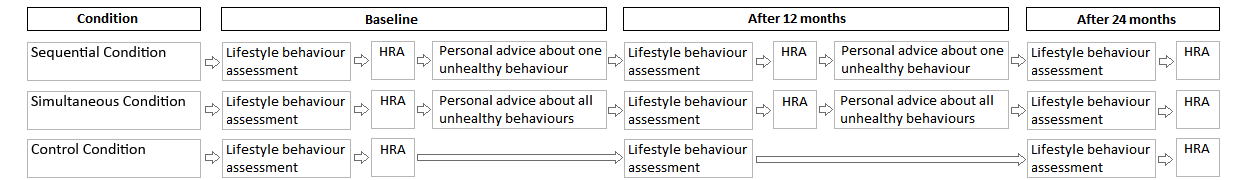
Figure 2. Design of the study. HRA: health risk